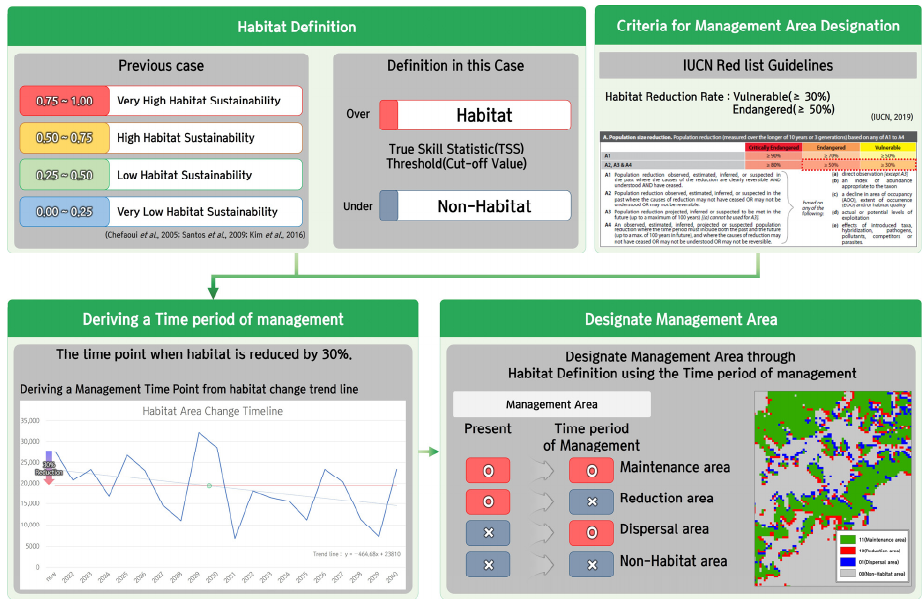
Figure 2. Flow chart depicting designation of management area using time period of management derived from the habitat definition and designation criteria (IUCN, 2019) [41].